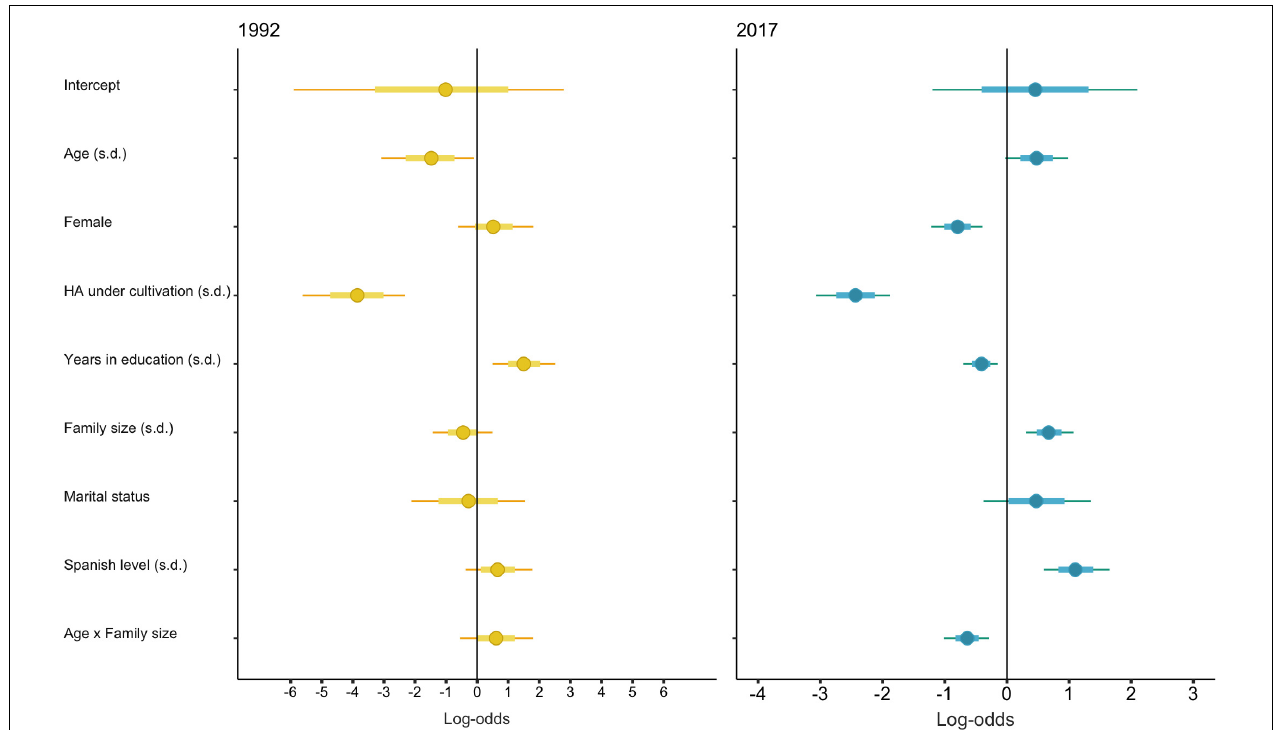
FIGURE 4 | Log-odds from the posterior distribution of the full multilevel logistic mixed model showing the probability that individuals over 16 years of age engaged in wage labor in 1992 (left) . and 2017 (right) . Points show median probability that an individual engaged in wage labor, thick lines are 50% HPDIs, and thin lines are 90% HPDIs. A vertical line represents no effect. All continuous parameters are standardized within each time period.